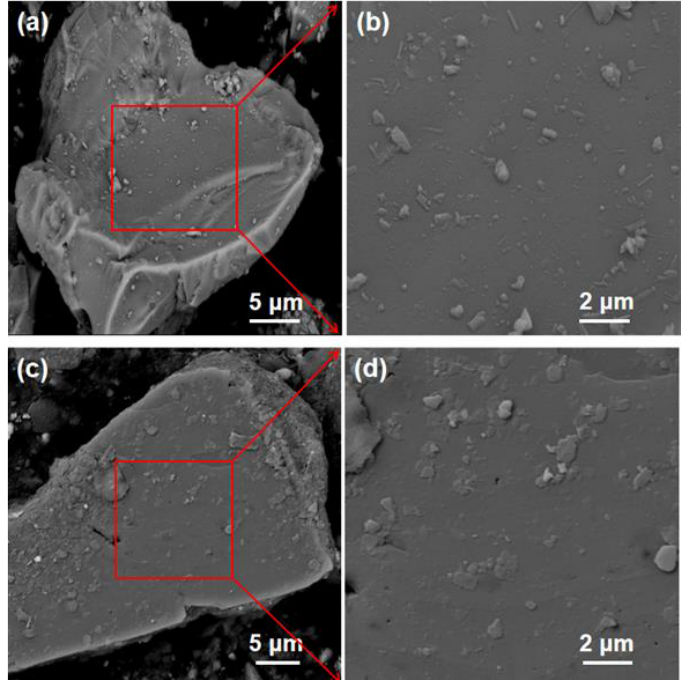
Figure 2. XRD pattern of BP. Phase identified: Kaolinite, Al 4 (OH) 8 (Si 4 O 10 ), PDF No. 78-2109; Quartz,